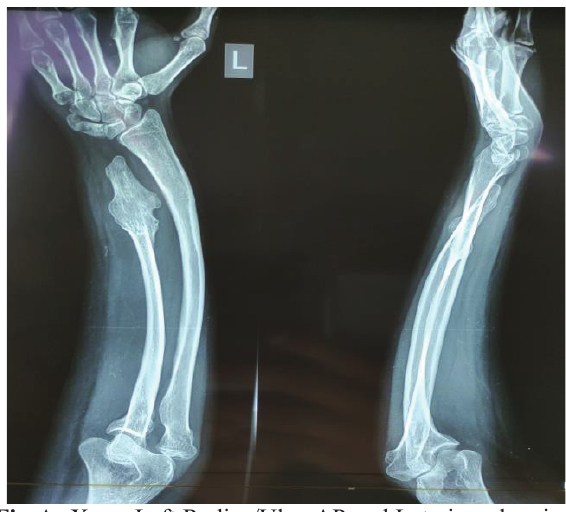
Fig-A: X-ray Left Radius/Ulna AP and Lat view showing distal